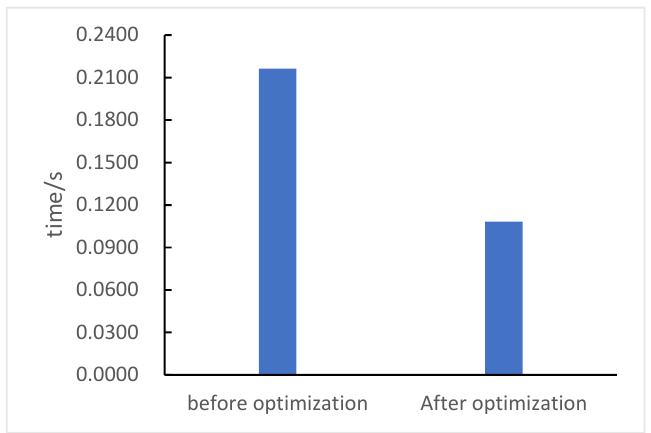
Figure 23. predict_time comparison before and after RF optimization.